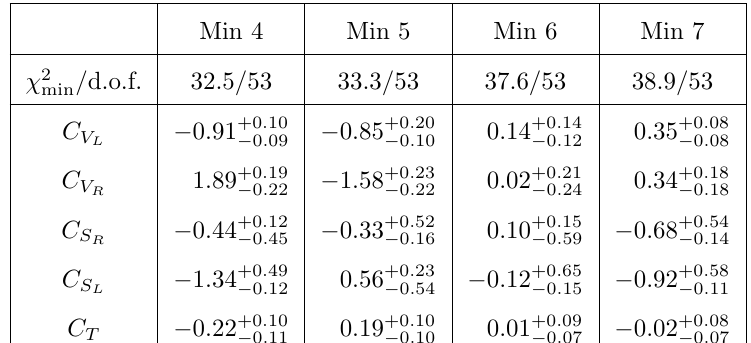
Table 6 . Minima with their 1 (cid:27) uncertainties obtained from the global (cid:31) 2 minimization, including F D (cid:3) and ( B c (cid:28) (cid:22) (cid:23) (cid:28) ) < 10% in the (cid:12)t while allowing for C V L B ! corresponding sign-(cid:13)ipped minima, as indicated in eq. (3.3).